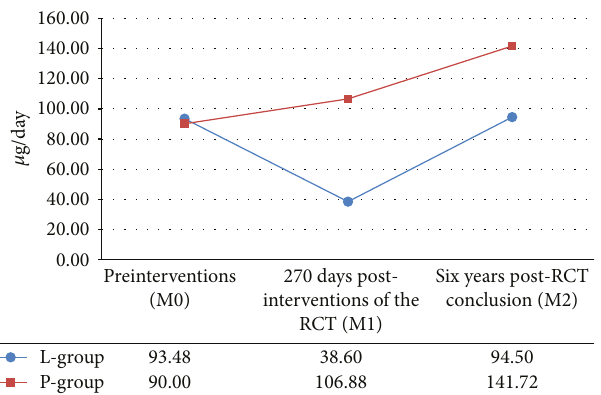
Figure 2: Replacement doses of LT4 ( μ g/day) required by the patients of the L and P groups at M0, M1, and